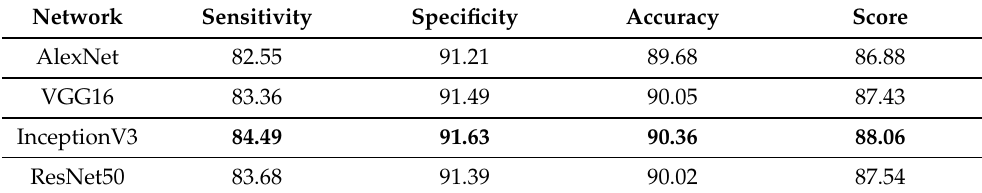
Table 2. Results regarding the classification of the PCG signals included in the PhysioNet dataset (best found values are in